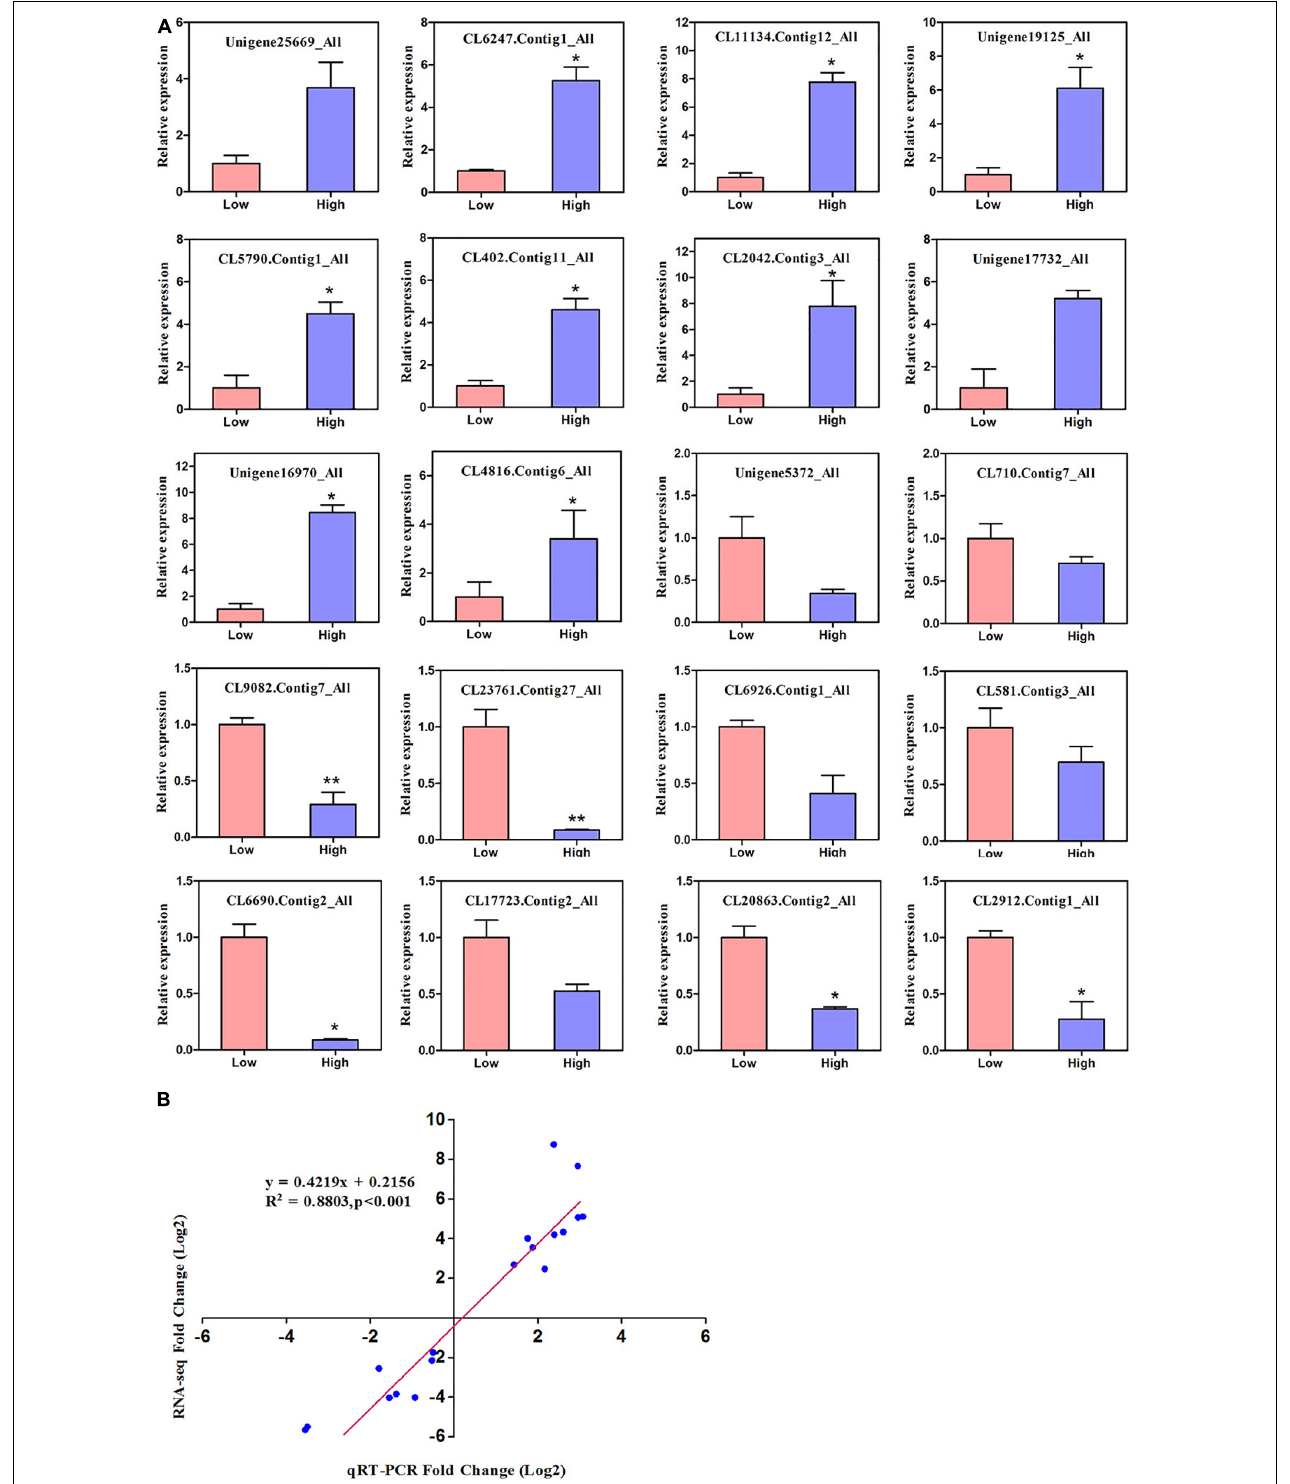
FIGURE 6 | The relative expression levels of 20 DEGs identified in the comparison between RNA-Seq and qRT-PCR. (A) The gene relative expression levels were normalized to the expression level of UBC. Error bars represented the standard deviations of three PCR replicates. Significant differences from the low altitude were denoted by one or two asterisks corresponding to P < 0 . 05 and P < 0 . 01, respectively, by the Student’s t -test. (B) R-values are the correlation coefficients between qRT-PCR and